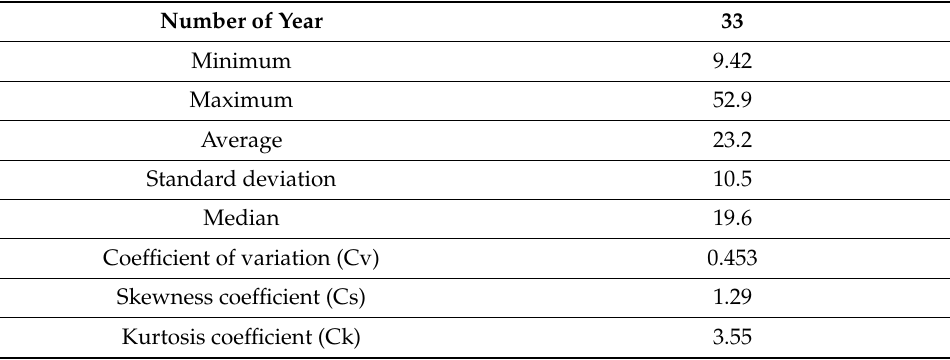
Table 4. Summary of rainfall for the study area